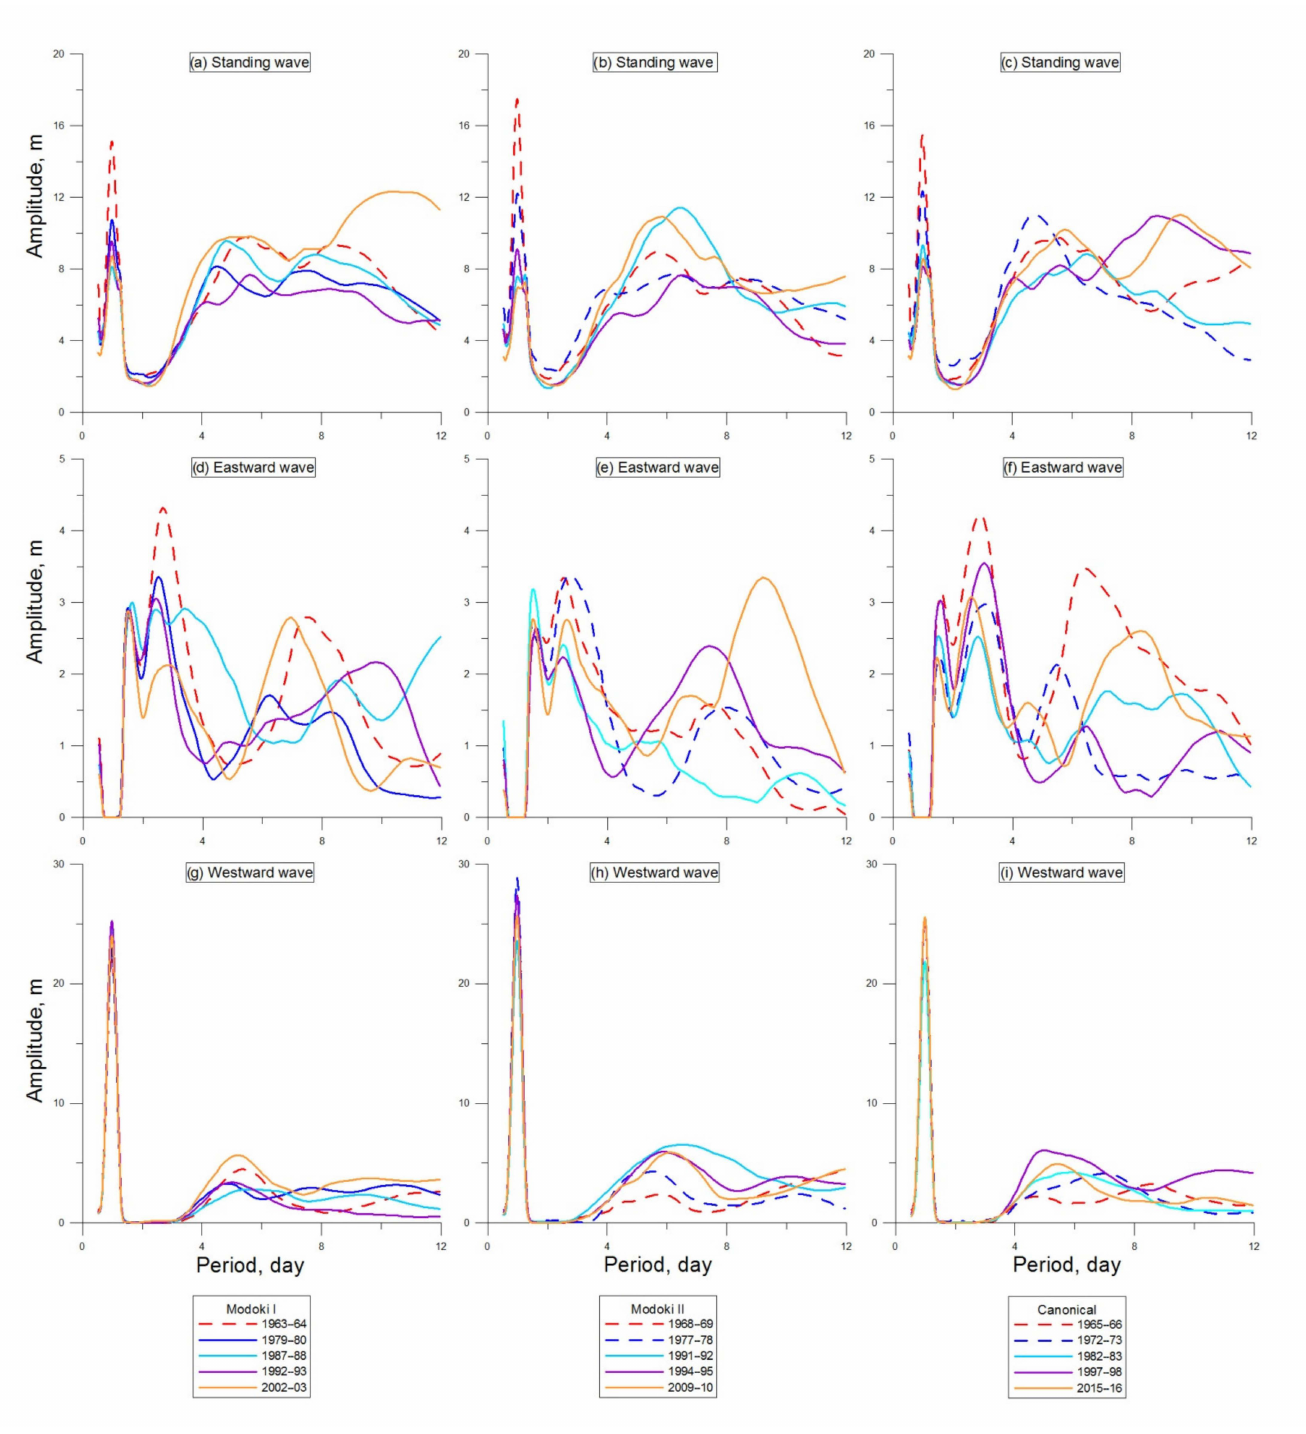
Figure 6. Standing waves ( top panels ), eastward waves ( middle panels ), and westward waves ( bottom panels ) averaged over 5 months (from November to March) during Modoki I ( left ), Modoki II ( middle ), and canonical El Niño ( right ) at 2.5 ◦ N. The dashed curves correspond to the wave amplitudes observed in winters before